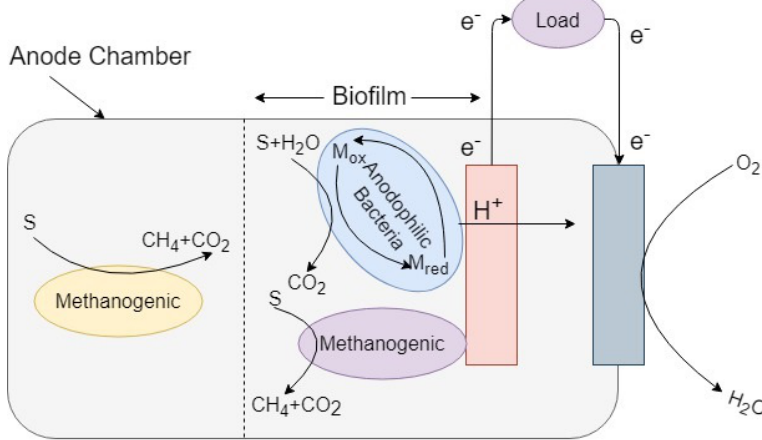
Figure 1. Single Chamber two-population Microbial Fuel Cell without